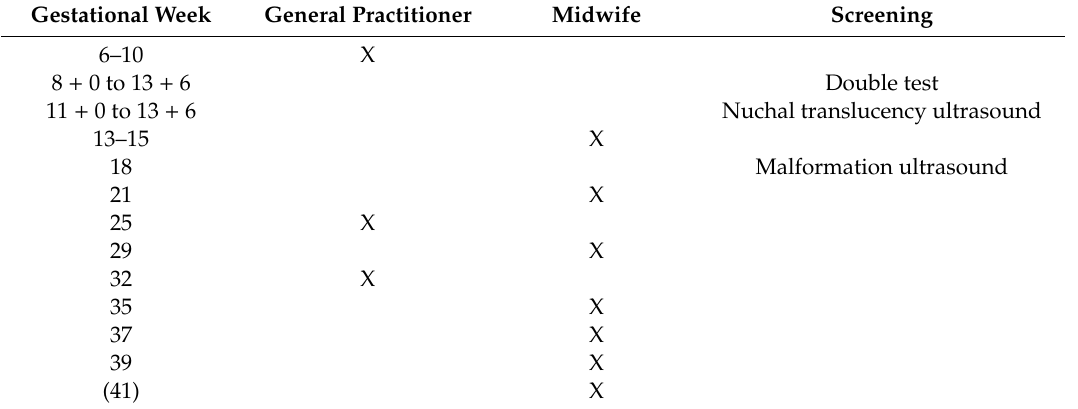
Table 1. The national recommendation for timing of antenatal care contacts for women enrolled in standard antenatal care